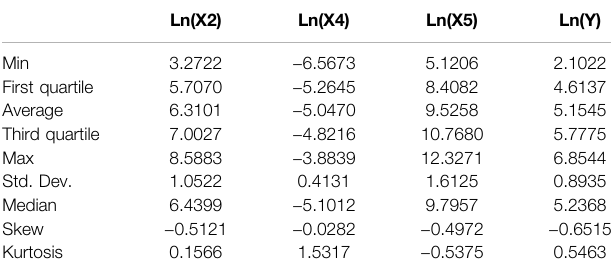
TABLE 2 | Descriptive statistics for Ln(X2), Ln(X4), Ln(X5), and Ln(Y) between 2000 and 2015.